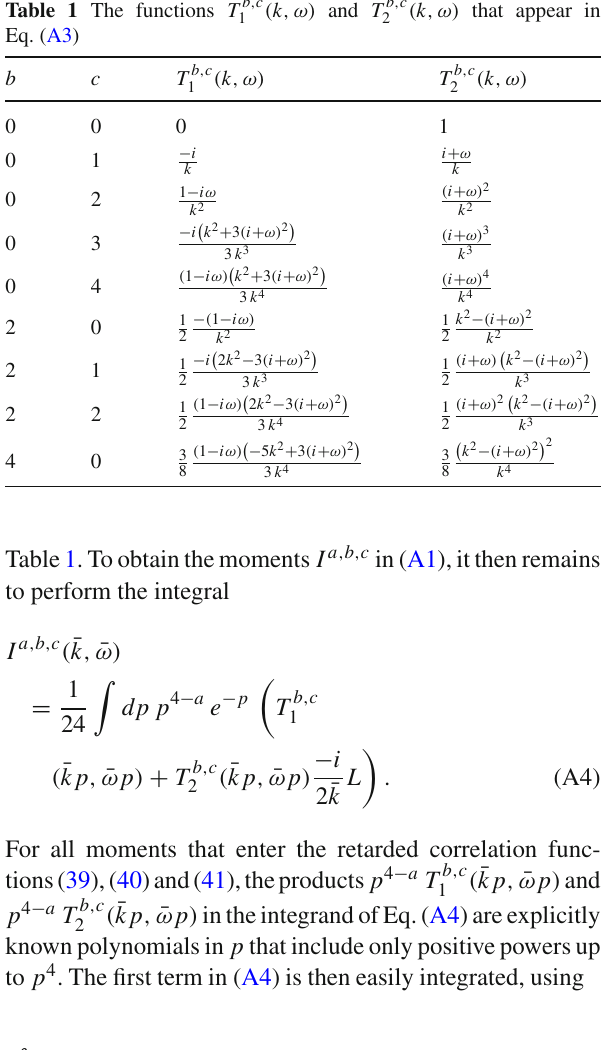
Table 1 The functions T b , c